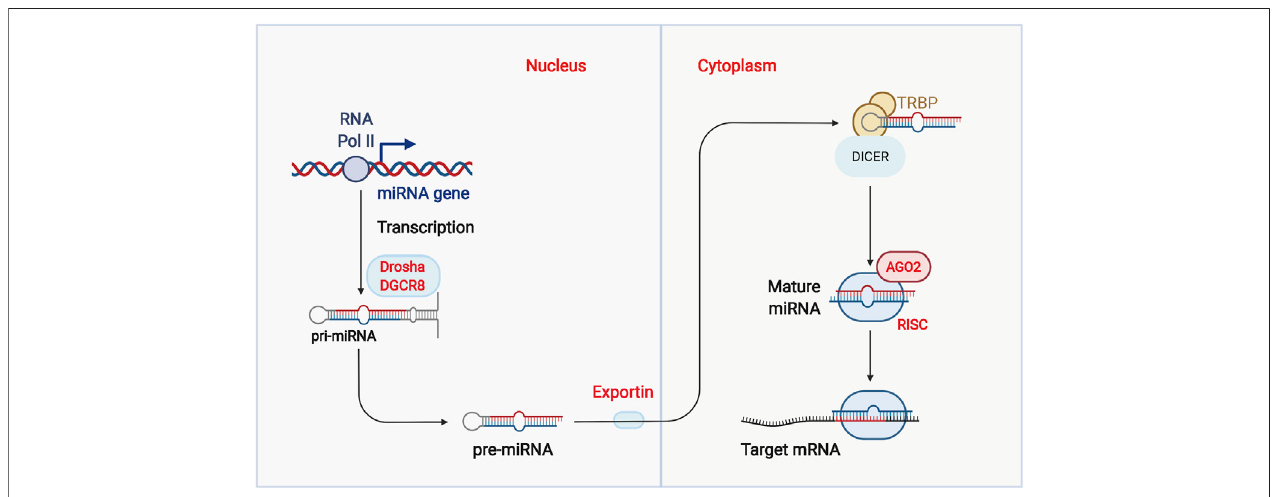
FIGURE 3 | Biogenesis of micro RNAs (miRNAs). RNA polymerase II regulates the transcription of miRNAs. As pri-miRNAs are transcribed, pri-miRNAs are processed by several sequential cleavages to produce mature miRNAs. Finally, mature miRNAs are integrated into Argonaute to form the miRNA-induced silencing complex (RISC).